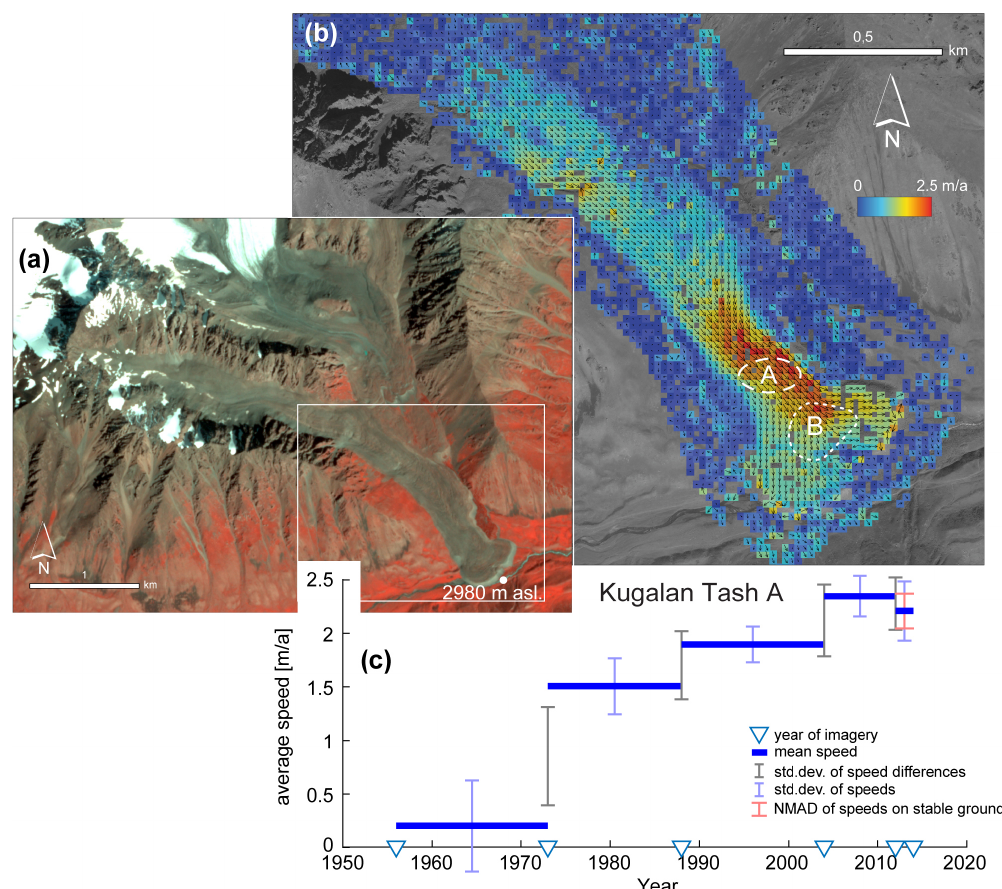
Figure 7. Velocities and speed variations on the Kugalan Tash rock glacier. (a) Overview image; © Planet image on 7 September 2016 in near-infrared false colour. (b) Colour-coded velocity field with vectors superimposed from image matching between 2012 and 2014 high-resolution satellite images (for exact dates and sensors see Table S2). Background image: WorldView1, 23 September 2012, ©Maxar. (c) Average time series of speeds for cluster of points A (white dashed outline in panel b ). Error bars give standard deviations of speeds within the point clusters (blue), standard deviations of speed differences within the measurement periods (grey), and the NMAD of stable ground offsets (red, 2012–2014 only) in m/a. Blue triangles on the time axis indicate years of imagery used. Also, results for zone B show an increase in speed over 1956–2014 (from 0.7 to 1.8m/a), but changes are for the most part within the error bars and therefore not